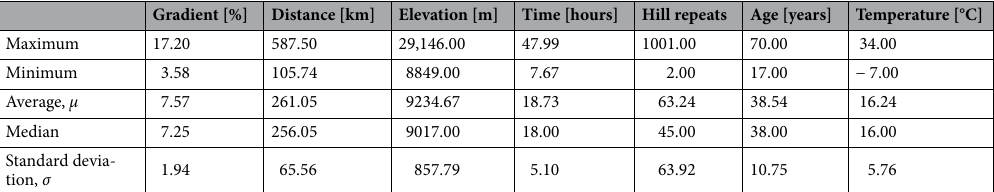
Table 1. Descriptive statistics of the Everesting